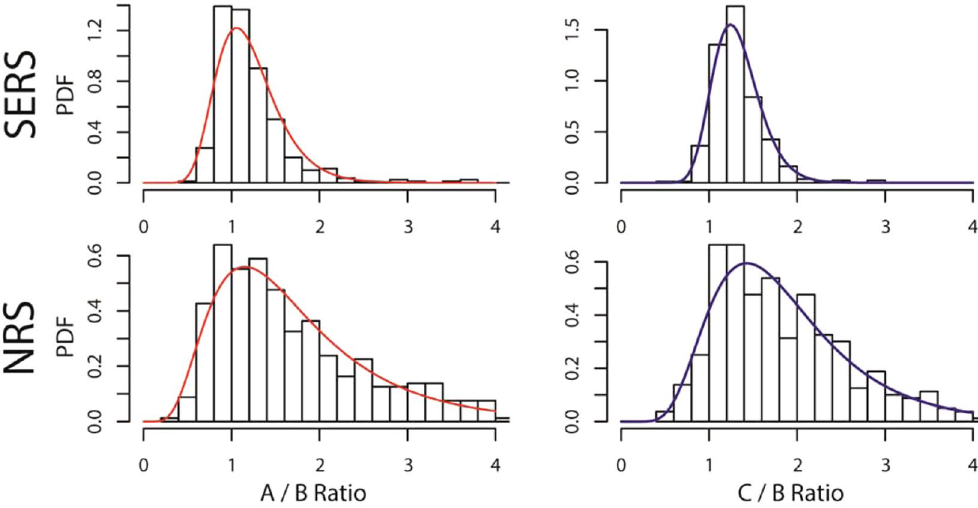
Figure 5. Comparison of SERS and NRS for the 50% A/50% C standard, showing a tighter distribution for the SERS